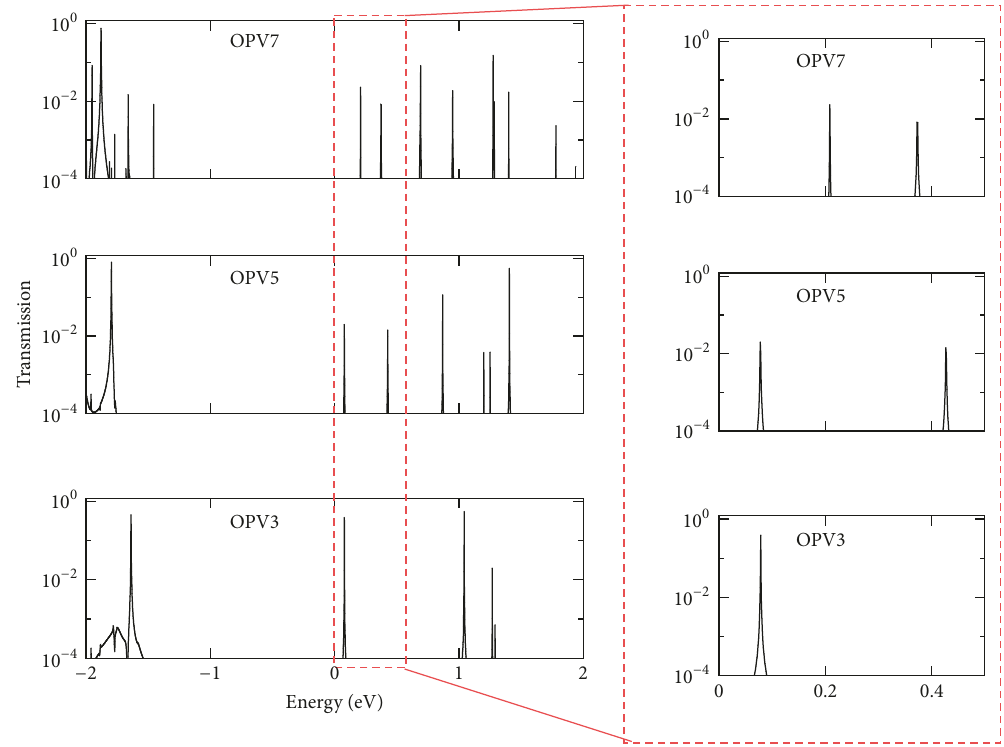
Figure 13: TS for molecules of different length OPV3, OP5, and